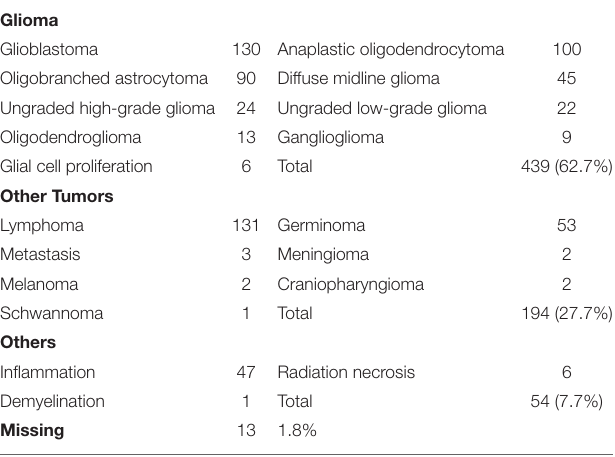
TABLE 1 | Breakdown of observations and diagnoses.